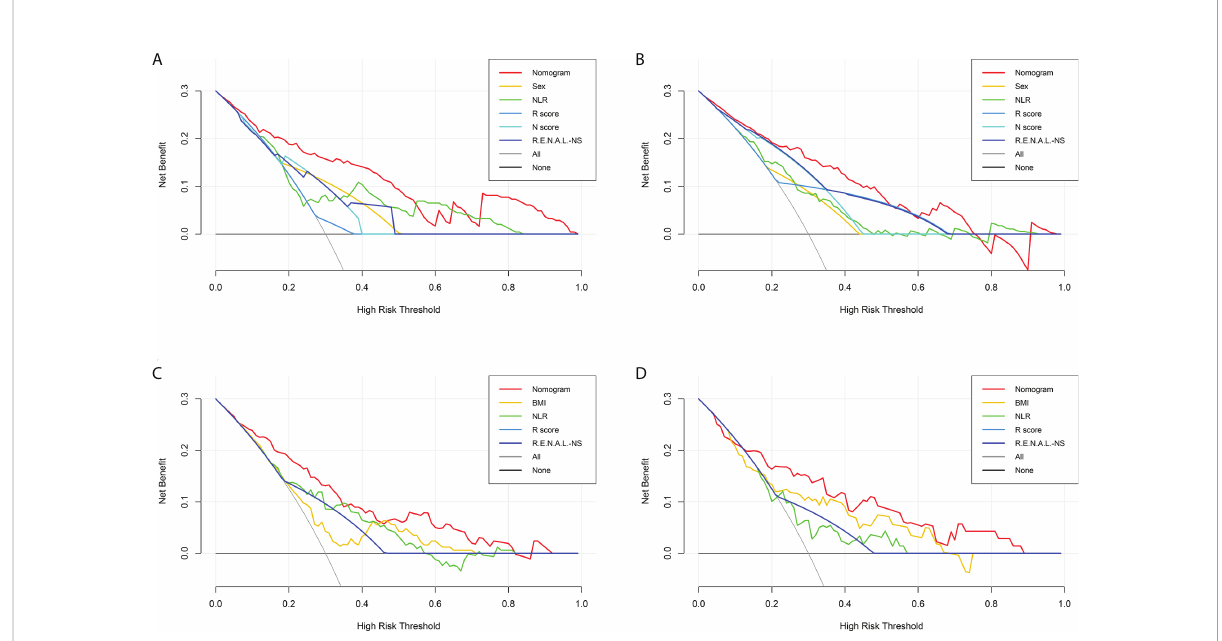
FIGURE 5 Decision curve analysis for the malignant histology-risk nomogram (A, B) and unfavorable pathology-risk nomogram (C, D) for evaluating the clinical utility in the training set (A, C) and validation set (B, D) . NLR, neutrophil to lymphocyte ratio; R.E.N.A.L.-NS, RENAL- Nephrometry Score; BMI, body mass